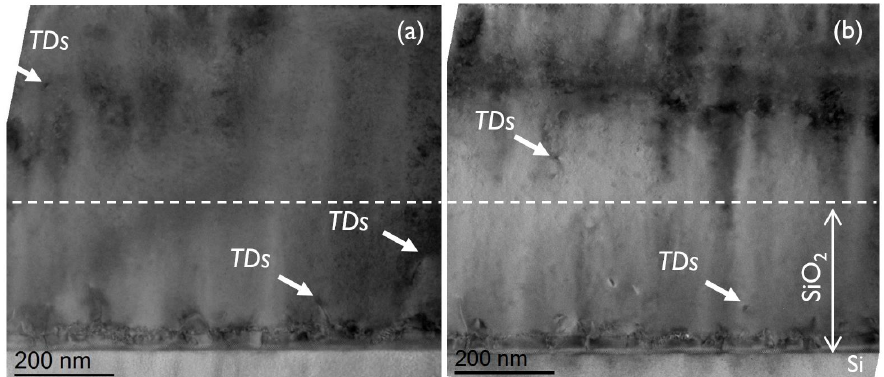
Figure 5. Two standard TEM images ( a ) and ( b ) acquired along the trench orientation of the GaSb NR sample with an InAs seed. The white dashed lines indicate the height of the trench oxide.